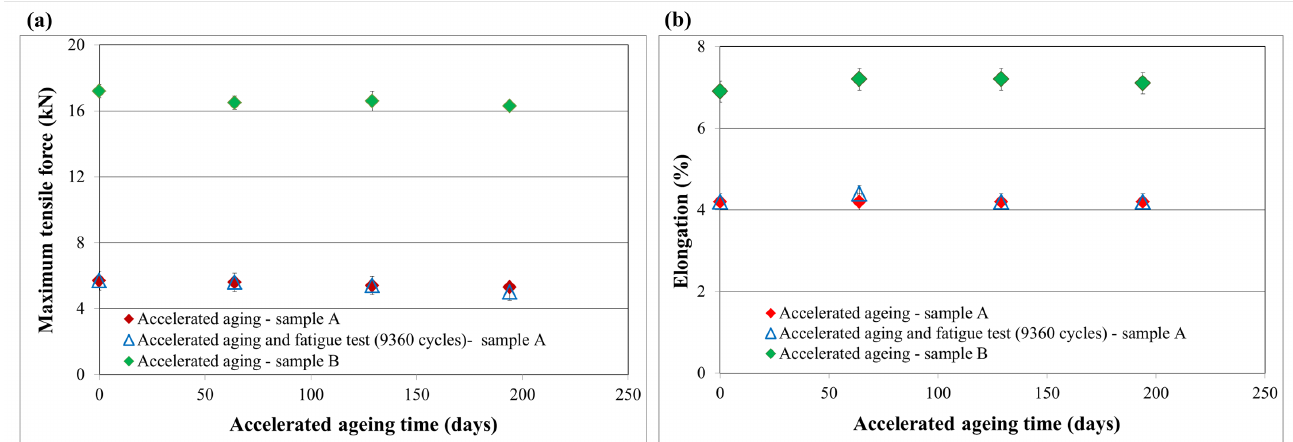
Figure 4. Maximum tensile force ( a ) and elongation ( b ) results for samples A and B.